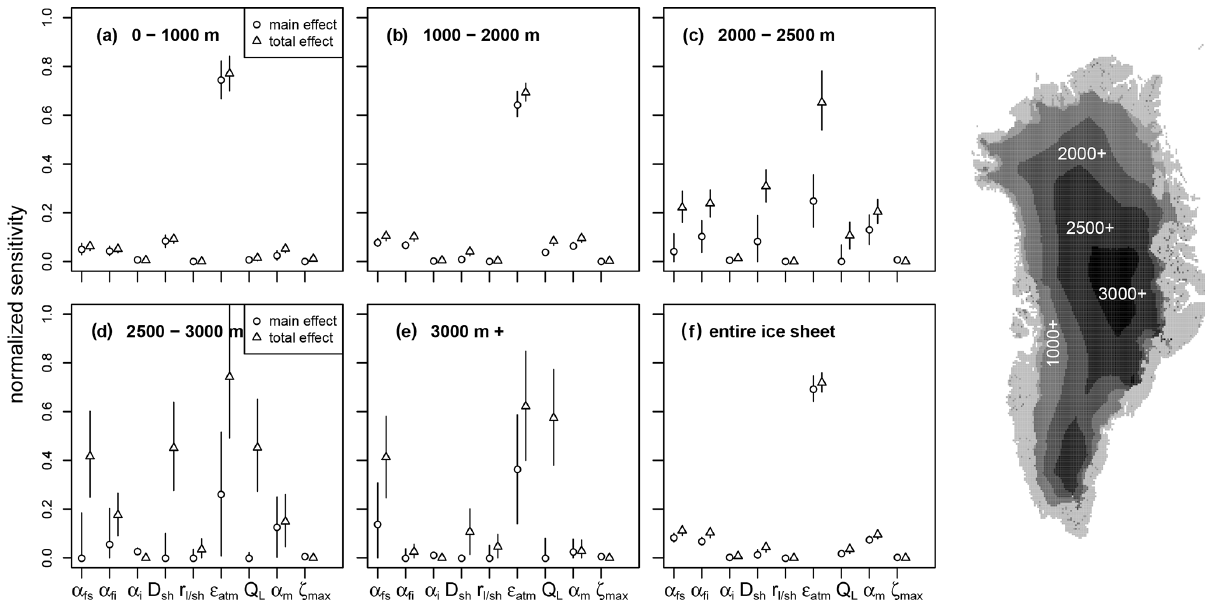
Figure 2. The global sensitivity analysis of the PD SMB provides the main-order effect (circle) and the total effect (triangle). The main-order effect shows the model sensitivity to the parameter alone, and the total includes its interaction with other parameters (Sect. 2.3). The two indices are displayed for all nine parameters over the different elevation bands ranging from 0–1000, 1000–2000, 2000–2500, and 2500– 3000 to above 3000m and for the entire ice sheet. The symbol represents the mean value of the sensitivity index with the bars as ± 1 σ . The elevation bands of the present-day topography over Greenland are displayed on the right; the analysis is only performed for cells where ice is present. A similar figure for the LGM is found in the Appendix (Fig.